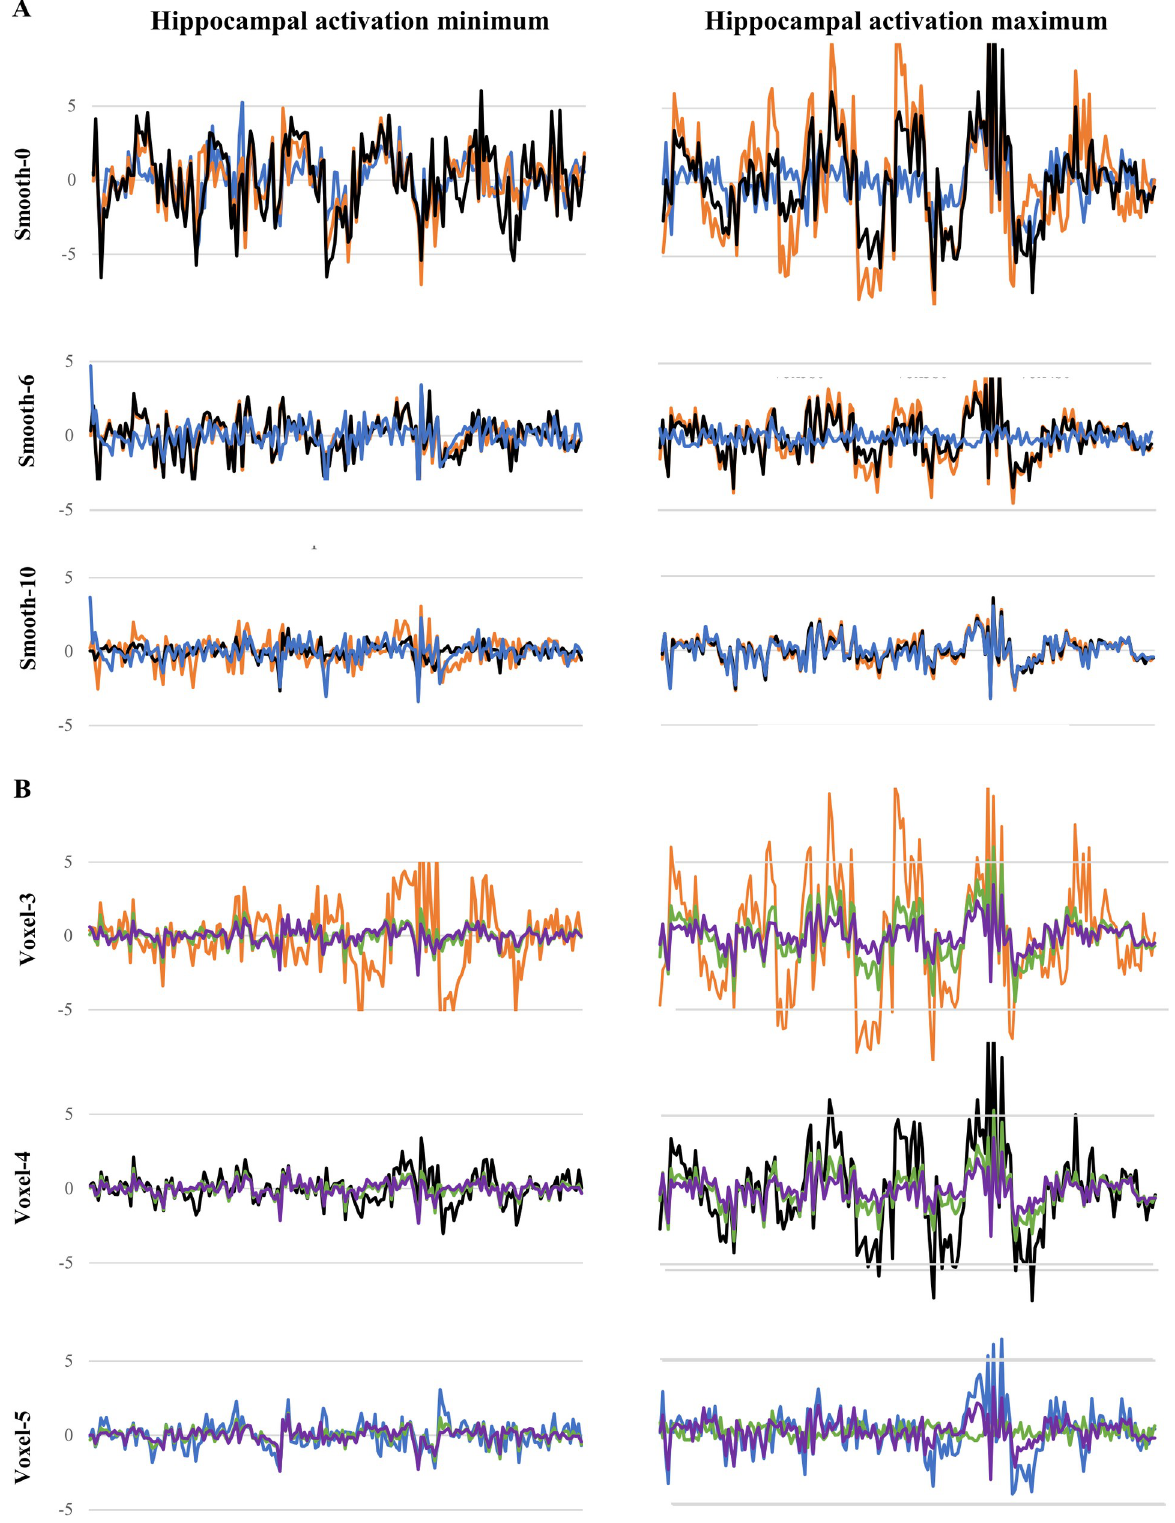
Fig 3. Effects of smoothing and voxel size on the temporal waveform of task activity in the hippocampus. (A) Effects of voxel size on temporal waveforms of signal intensity across the duration of the task, plotted separately for different smoothing kernels. At the activation maximum,